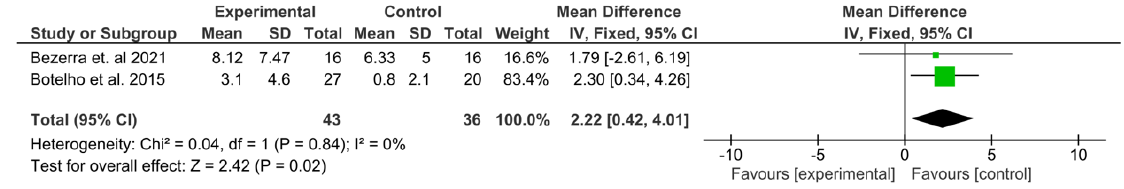
Figure 4. Comparison of experimental and control, according to dynamometry. SD: standard devi- ation; 95% CI: 95% confidence interval.